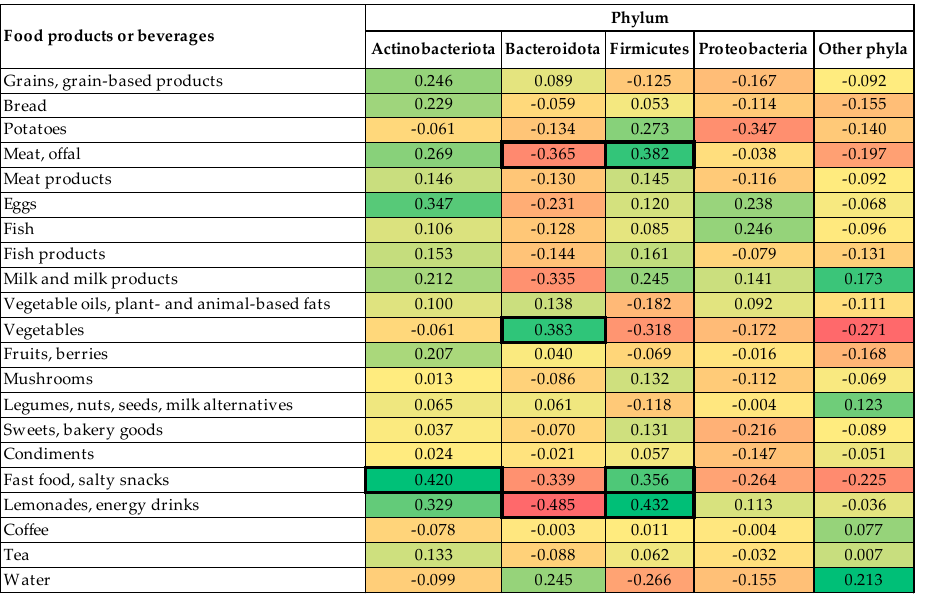
Figure 3. Spearman’s correlations between the abundances of gut microbiome at the phylum level and food and beverage intake among the study participants. Red: negative correlations; yellow: no correlation; green: positive correlations. p -value < 0.05 for bolded cells.